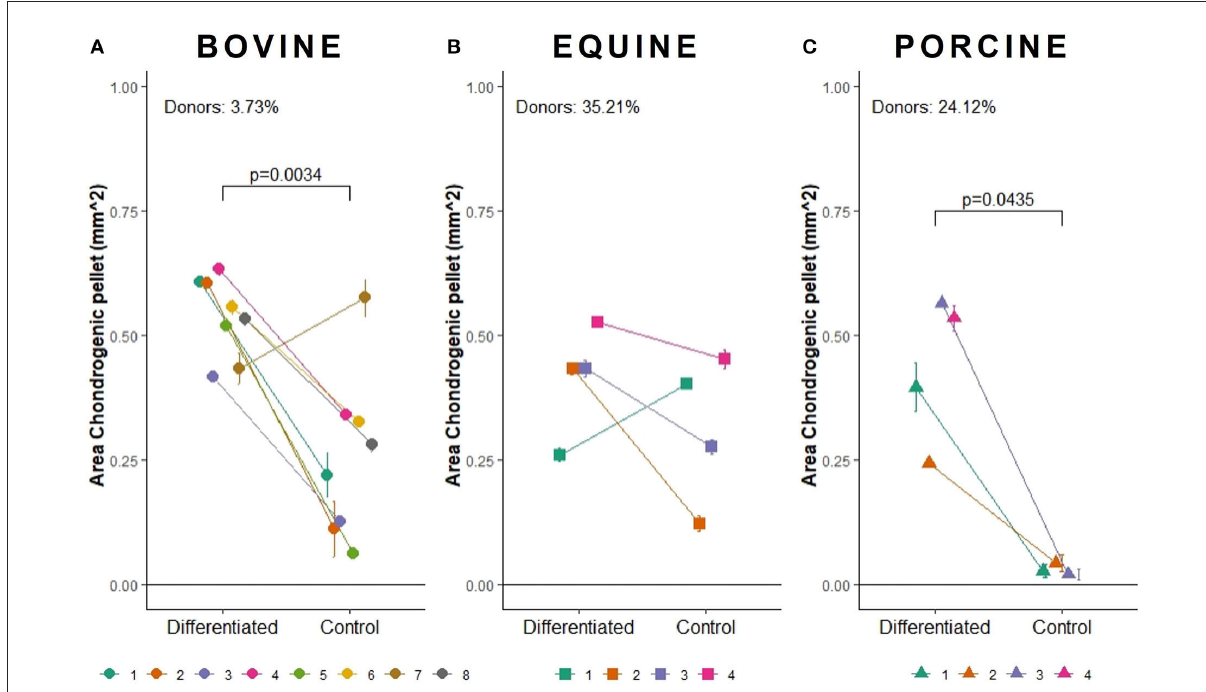
FIGURE4 Area measurement (in mm 2 ) to determine the pellet size of chondrogenically induced (A) bovine MSCs ( n = 8), (B) equine MSCs ( n = 4), and (C) porcine MSCs ( n = 4). The mean of chondrogenic pellet area with standard deviation is